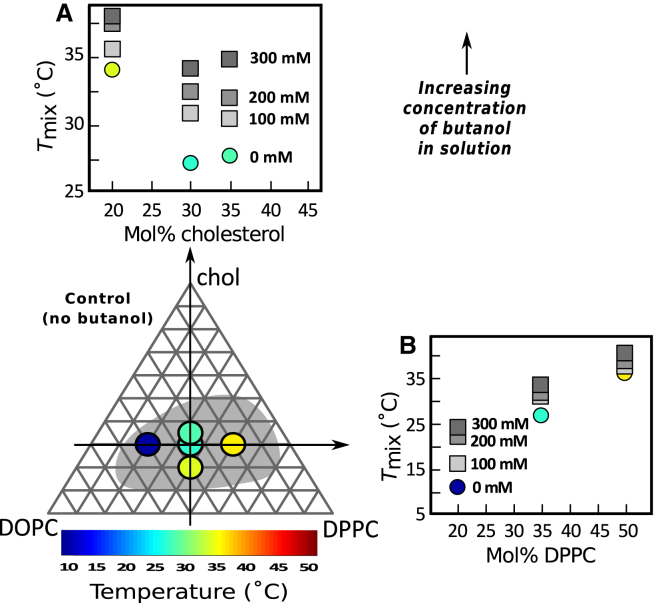
Miscibility transition temperatures of GUVs of five different ratios of DOPC/DPPC/cholesterol increase with the concentration of butanol in solution. Colors within circles on the Gibbs triangle record Tmix in the absence of butanol; corresponding Tmix values are plotted in (A) and (B). The gray region denotes compositions over which a transition from one uniform phase to coexisting Lo and Ld phases is observed at a temperature between 15 and 40°C, from (29). GUVs in (A) contain increasing cholesterol fractions (following the vertical arrow on the triangle). GUVs in (B) maintain a constant fraction of cholesterol (following the horizontal arrow). Each point represents a single experiment for which uncertainties are smaller than symbols. To see this figure in color, go online.